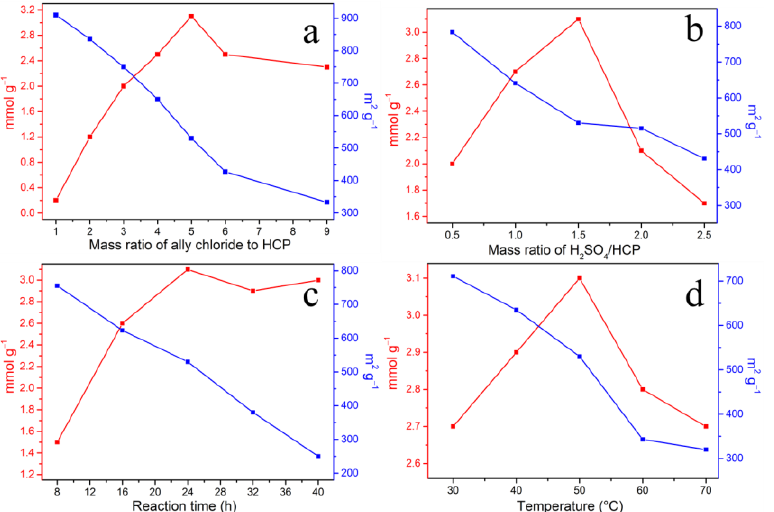
Figure 1. Effects of reaction conditions on specific surface area and content of the chloromethyl group of HCP-CH 2 -Cl: ( a ) mass ratio of ally chloride to HCP, mass ratio of H 2 SO 4 / HCP = 1.5, 50 °C, 24 h; ( b ) mass ratio of H 2 SO 4 / HCP, mass ratio of ally chloride to HCP = 5, 50 °C, 24 h; ( c ) reaction time, mass ratio of ally chloride to HCP = 5, mass ratio of H 2 SO 4 / HCP = 1.5, 50 °C; ( d ) reaction temperature, mass ratio of ally chloride to HCP = 5, mass ratio of H 2 SO 4 /HCP = 1.5, 24 h.